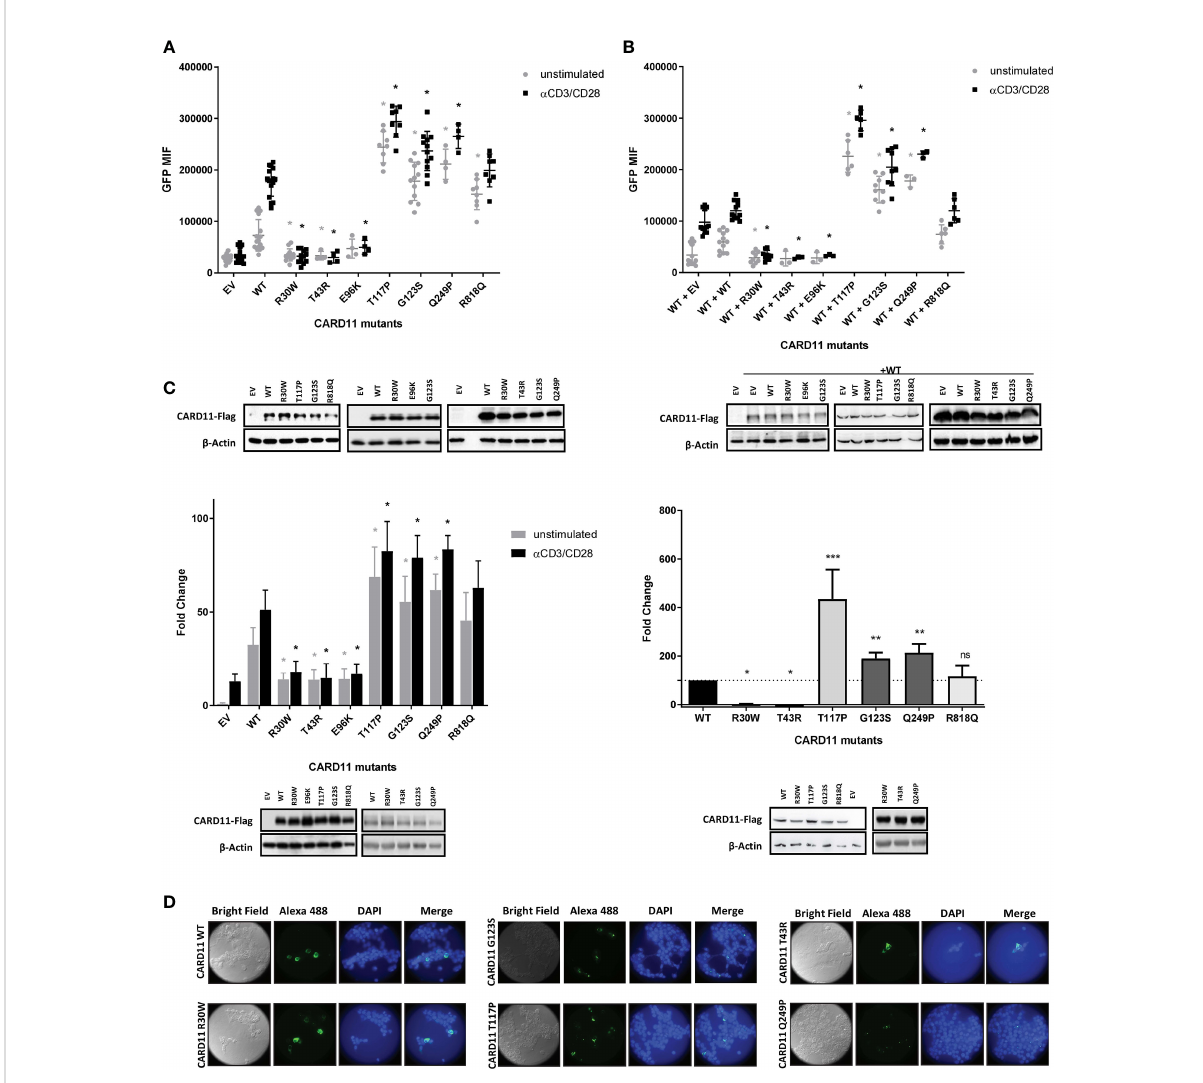
FIGURE 2 Reporter gene assays of CARD11 variants in JPM50.6,Jurkat T cells and HEK293T cell lines. (A) Quanti fi cation of Flow cytometric NF- k B-driven GFP reporter expression in JPM50.6 cells transfected with empty vector (EV), WT or mutant CARD11 constructs, unstimulated or stimulated with anti-CD3 and anti-CD28 for 24 h. (mean fl uorescence intensity (MFI) of GFP+ cells). Data are mean ± s.e.m. (EV and WT n=16; p.R30W and p.G123S n=12, p.T117P and p.R818Q n=8; p.T43R, p.E96K and p.Q249P n=4) Two-way ANOVA with Sidak ’ s multiple t-test. *p<0.05 for each mutant versus WT with or without stimulation (EV<0.0001, <0.0001; p.R30W p=0.0110, <0.0001; p.T43R p=0.0485, <0.0001; p.E96K p=0.4627, <0.0001; p.T117P p<0.0001, <0.0001; p.G123S p<0.0001, <0.0001; p.Q249P <0.0001, <0.0001; p.R818Q p<0.0001, p=0.3119). (B) Quanti fi cation of Flow cytometric analysis (GFP MFI) of JPM50.6 cells transfected with WT CARD11 plus WT or mutant constructs and stimulated as in (A) . Data are mean ± s.e.m. (EV and WT n=12; p.R30W and p.G123S n=9, p.T117P and p.R818Q n= 6; p.T43R, p.E96K and p.Q249P n=3). Two-way ANOVA with Sidak ’ s multiple t test. *p<0.05 for each mutant versus WT with or without stimulation (EV p=0.0255, 0.0864; p.R30W p=0.0097, <0.0001; p.T43R p=0.1358, <0.0001; p.E96K p=0.1760, <0.0001; p.T117P p<0.0001, <0.0001; p.G123S p<0.0001, <0.0001; p.Q249P p<0.0001, <0.0001; p.R818Q p=0.7581, p>0.9999). (C) Left: Quanti fi cation of relative speci fi c activity of Luciferase assay in transfected Jurkat T cells with empty vector (EV), WT or mutant CARD11 and reporter luciferase constructs, and stimulated as in (A) . Data represent fold change in luciferase activity normalized to renilla activity. Data are mean ± s.e.m. (EV, WT, p.R30W andp.G123S n=12; p.T117P andp.R818Q n=6; p.T43R, p.E96K and p.Q249P n=3). Two-way ANOVA with Sidak ’ s multiple t test. *p<0.05 for each mutant versus WT with or without stimulation (EV p<0.0001, <0.0001; p.R30W <0.0001, <0.0001; p.T43R p=0.0333, <0.0001; p.E96K p=0.0384, <0.0001; p.T117P p<0.0001, <0.0001; p.G123S <0.0001, <0.0001; p.Q249P <0.0001, <0.0001; p.R818Qp=0.0712, p=0.1365). Rigth: Quanti fi cation of relative speci fi c activity of Luciferase assay in transfected HEK293T cells with empty vector (EV), WT or mutant CARD11 and reporter luciferase constructs. Data represent fold change in luciferase activity normalized to renilla activity. Data are mean ± s.e.m. Wilcoxon signed rank test *p<0.05, **p<0.01, ***p<0.005. (A – C) Immunoblot for CARD11-Flag expression in transfected cell lysates are at the bottom of each graphic b -Actin serves as a loading control. (D) HEK293T transfected with WT and CARD11 mutants constructs were analysed by confocal microscopy using anti-FLAG and Alexa-Fluor488-conjugated secondary Abs, nuclei were stained with DAPI. ns, not statistically signi fi